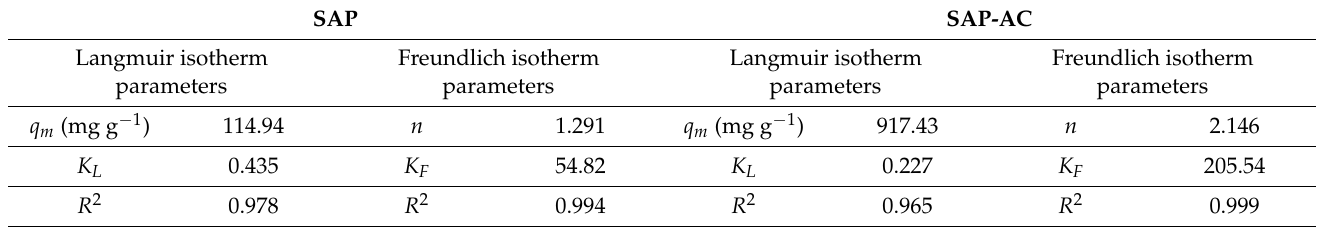
Table 4. Isotherm parameters of MB adsorption on SAP and SAP-AC as adsorbents.